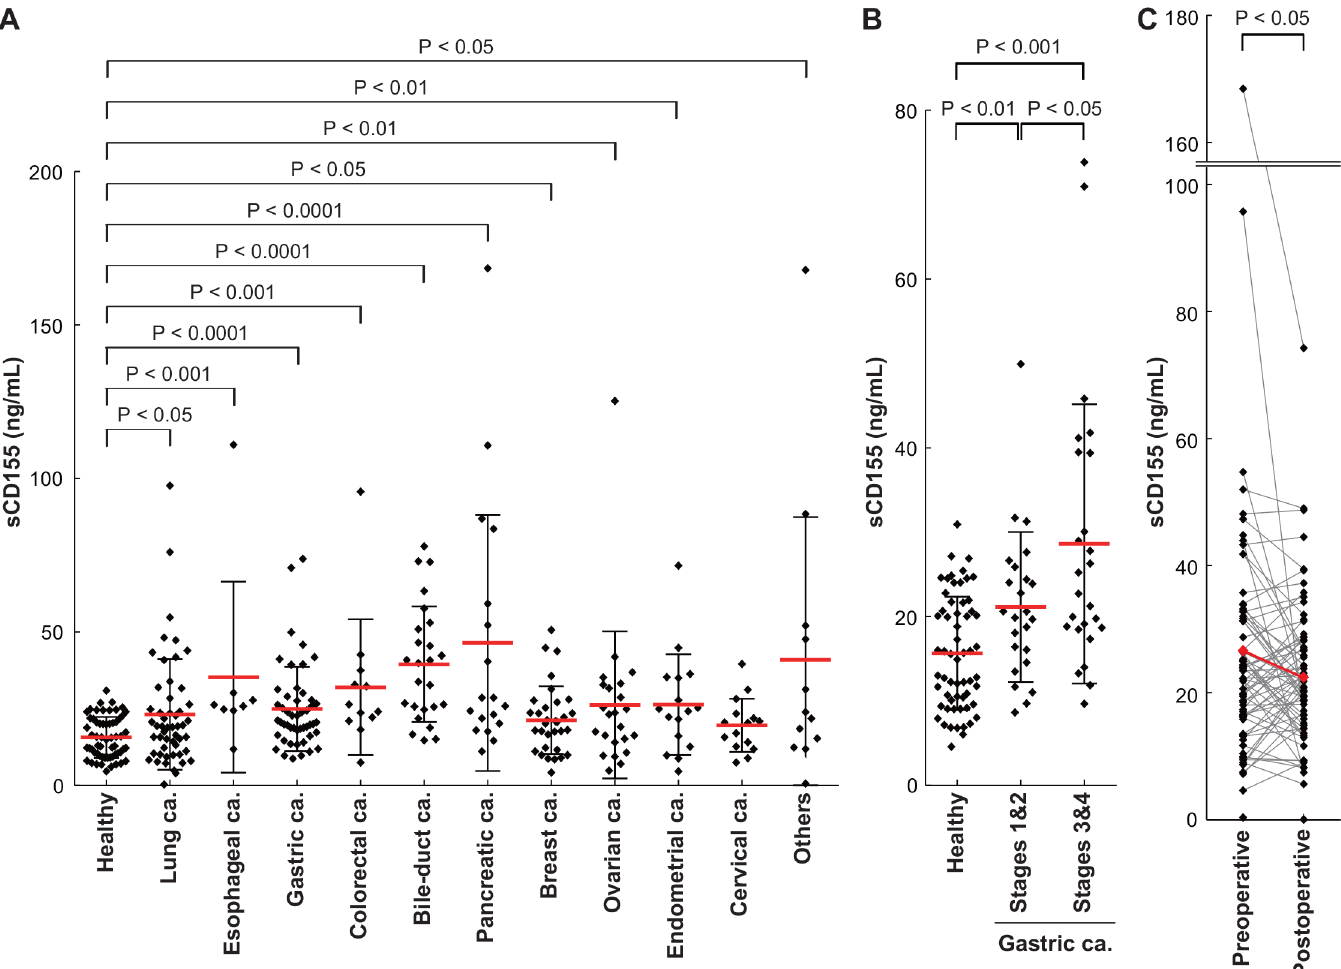
Fig 4. Soluble CD155 levels in sera of patients with various cancers. ( A ) Soluble CD155 levels in sera according to the various cancer types (lung: n = 52, esophageal: n = 8, gastric: n = 49, colorectal: n = 12, bile-duct: n = 25, pancreatic: n = 18, breast: n = 32, ovarian: n = 23, endometrial: n = 16, cervical: n = 15) analyzed by sandwich ELISA. Red bar: mean, black bar: SD. ( B ) Soluble CD155 levels in sera of gastric cancer patients stratified by disease stage. Stages 1&2: n = 24, stages 3&4: n = 25. ( C ) Soluble CD155 levels in sera of cancer patients who underwent surgery (n = 73) were analyzed for cancer before and after. Soluble CD155 level significantly decreased after operation. Red plot: mean, preoperative mean: 26.529 ng/mL, postoperative mean: 22.390 ng/ mL, P < 0.05. Postoperative days: 69.30 ± 61.95.